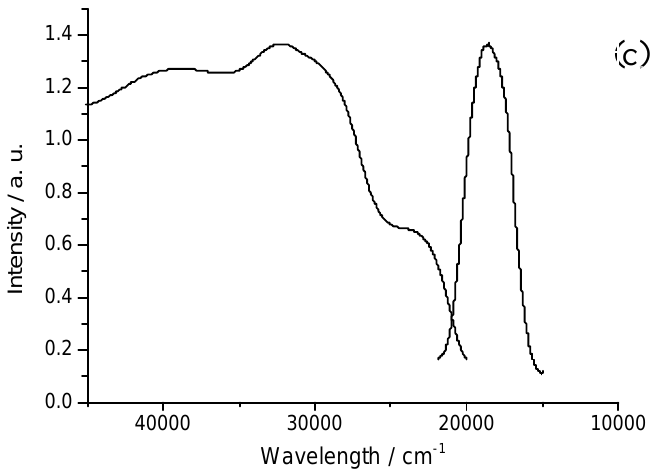
Figure 9: The normalized absorption and emission spectra of 3 in DMSO ( l = 25000 cm -1 ) (a), in nanoporous MCM-41 ( l exc and in pure crystals ( l = 24100 nm -1 ) (c) at room exc